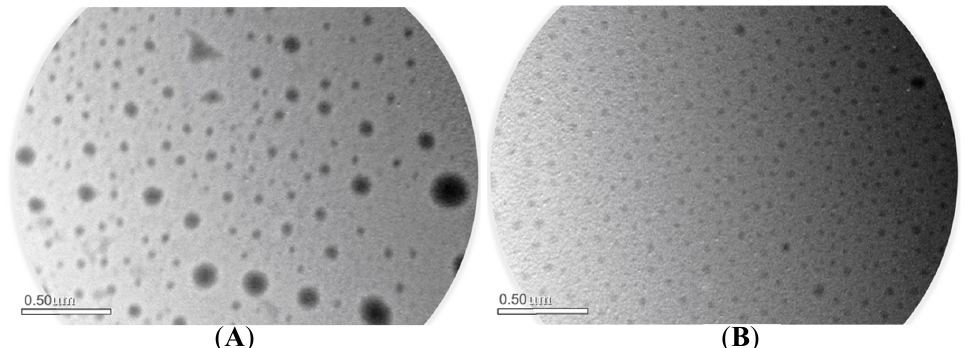
Figure 4. Size distribution of random ionomer aggregates formed in aqueous solution. The solid line is the Gaussian fit.